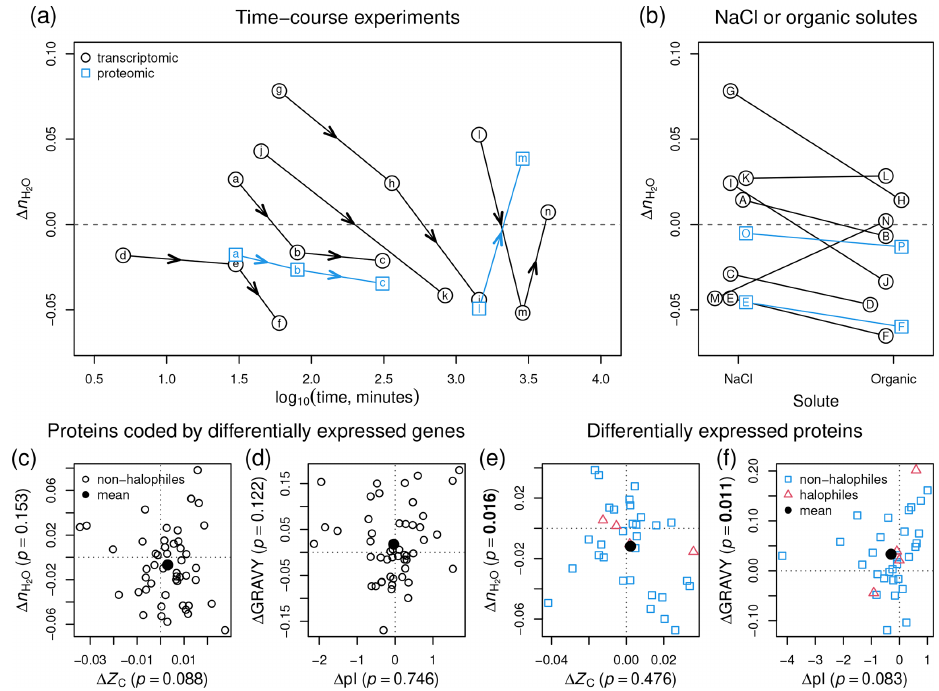
Figure 7. Compositional analysis of proteins in hyperosmotic stress experiments for non-halophilic bacteria and halophilic archaea. (a) Time- course experiments for bacteria; black circles represent datasets for proteins coded by differentially expressed genes (transcriptomics exper- iments) and blue squares represent datasets for differentially expressed proteins (proteomics experiments). Lettered symbols represent the